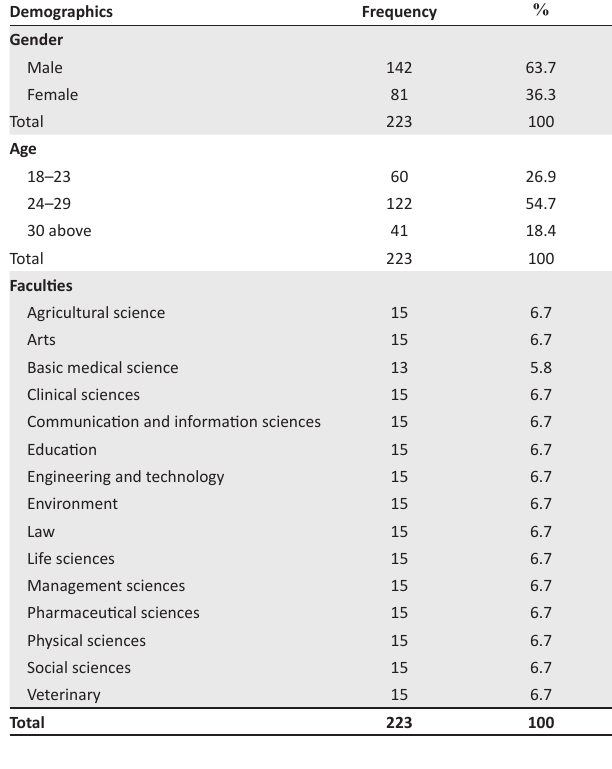
TABLE 1: Demography of the respondents.